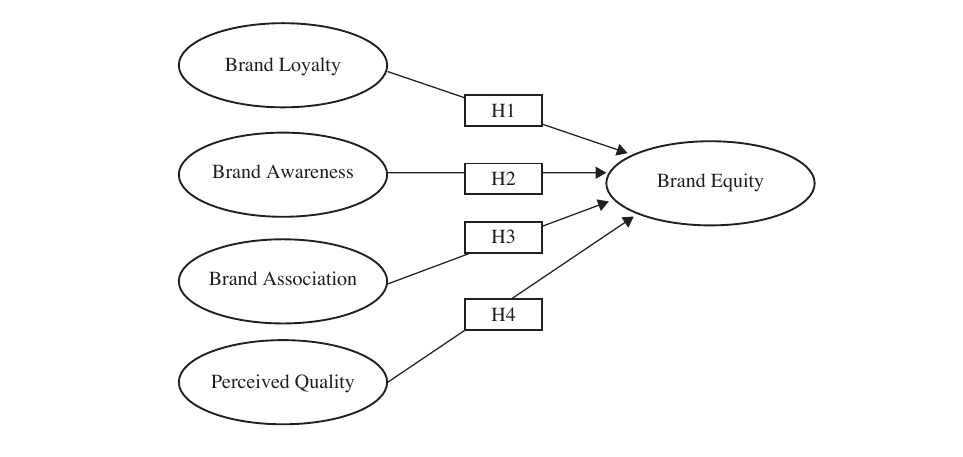
Figure 1: Conceptual